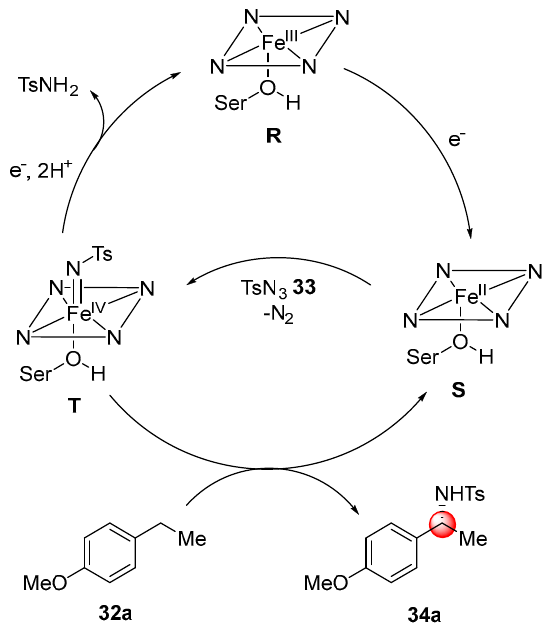
Scheme 18. Proposed mechanism for benzylic C ‒ H